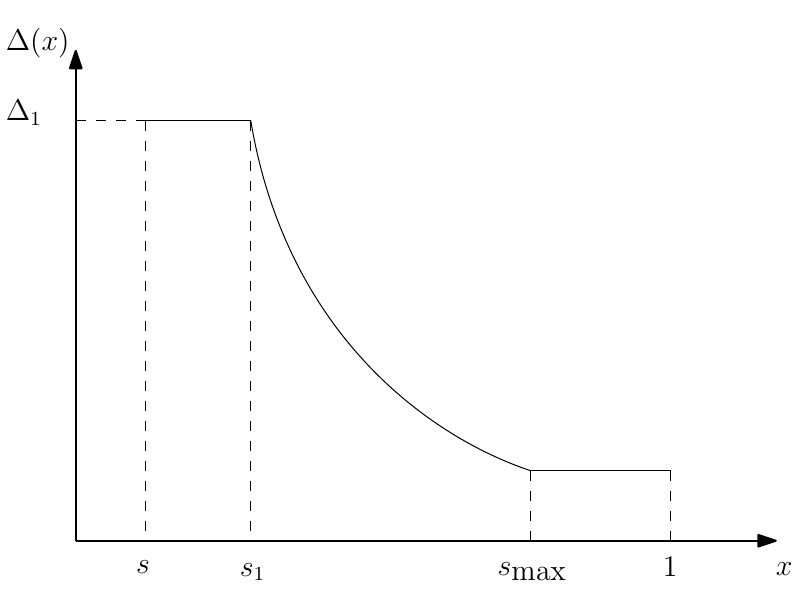
Figure 4: The generic profile of ∆ ( x ) within the fullRSB